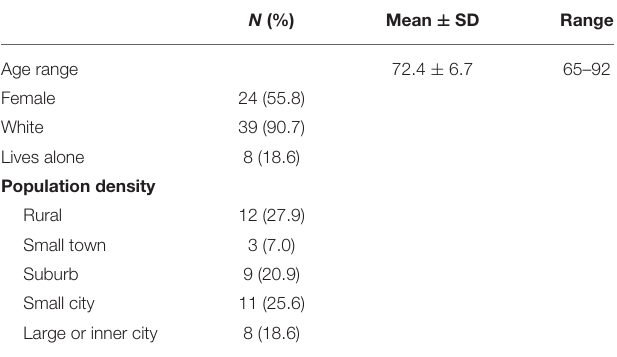
TABLE 2 | Participant characteristics ( n =